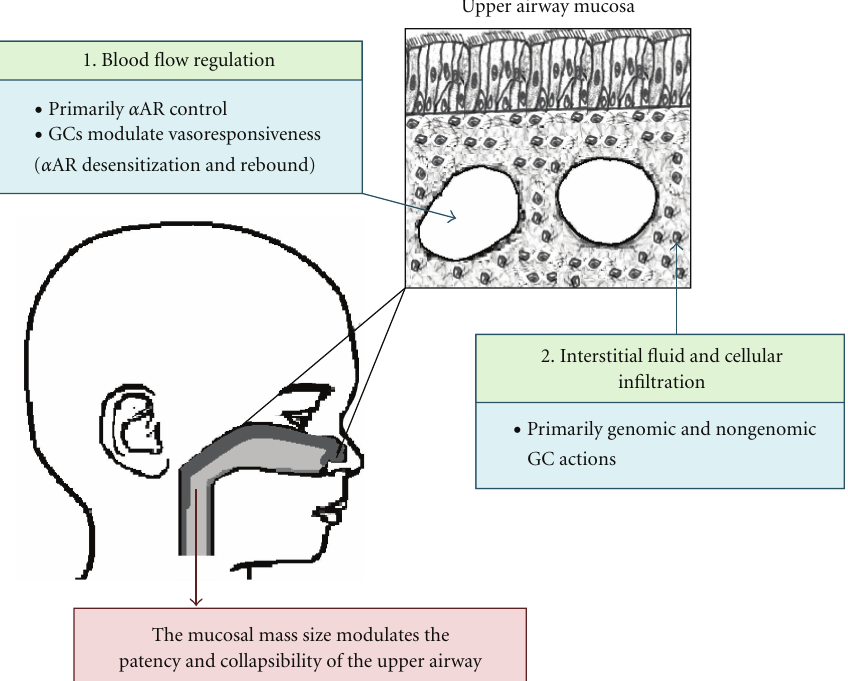
Figure 1: Regulatory e ff ects of alpha-adrenoreceptor-( α AR-) agonists and glucocorticoids (GCs) in the upper airway